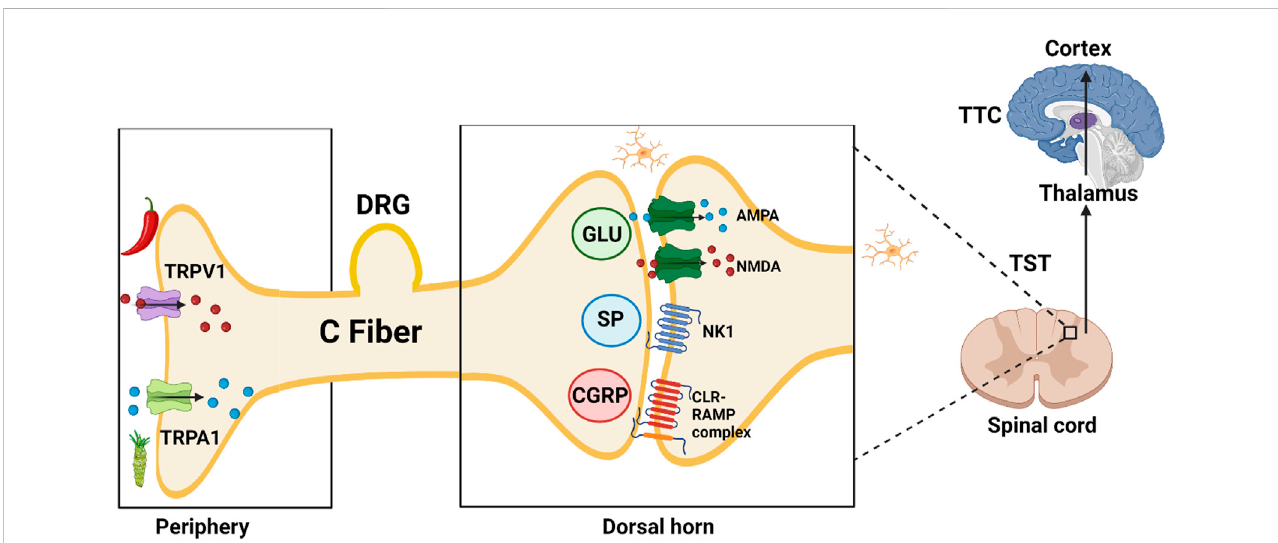
FIGURE 2 TRPV1, transient receptor potential vanilloid subfamily, member 1, capsaicin or hot chili pepper receptor; TRPA1, transient receptor potential ankyrin subfamily,member1,allylisothiocyanateorwasabireceptor;DRG,dorsalrootganglion;GLU,glutamate;SP,substanceP(11AA);AMPA, α -amino-3-hydroxy- 5-methyl-4-isoxazolepropionic acid; NMDA, N-methyl-d-aspartate; NK1, Neurokinin 1 receptor; CGRP, calcitonin gene-relatedpeptide (37 AA); CLR-RAMP, calcitonin like receptor — receptor activity modifying protein complex; TST, Tractus spino-thalamicus; TTC, tractus thalamo-corticalis; Ca 2+ ; Na + ; Microglia; Chili pepper: Capsaicin; Wasabi: Allyl isothiocyanate.